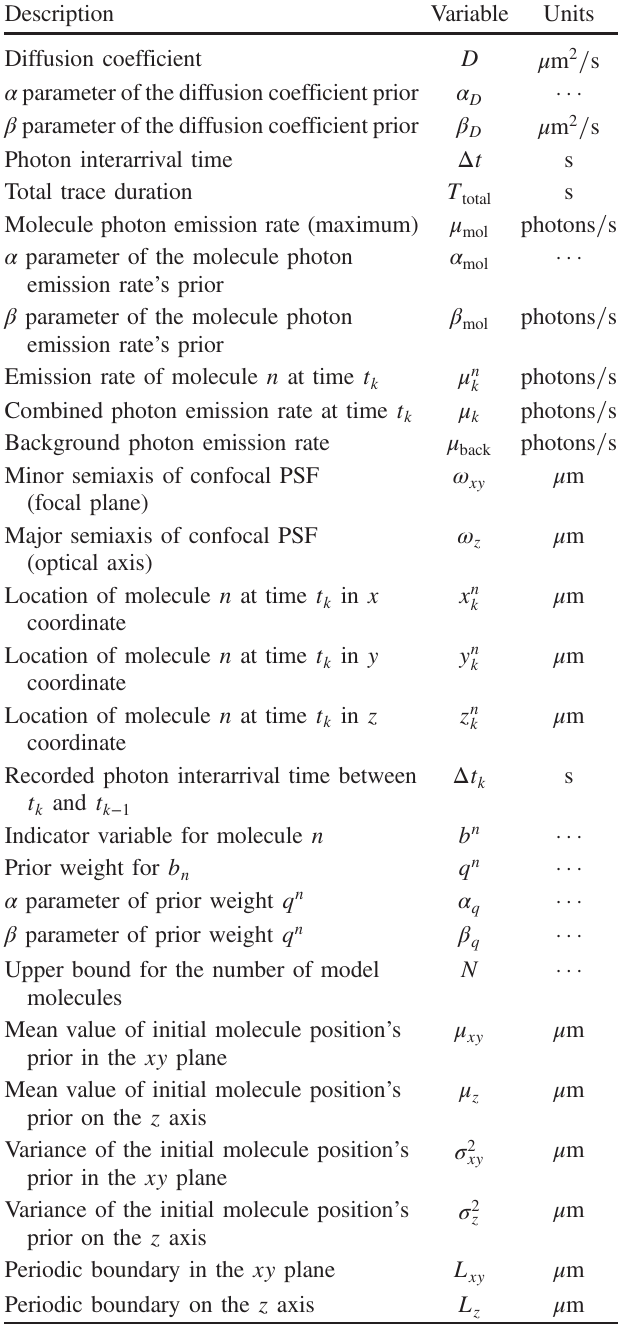
TABLE II. Summary of